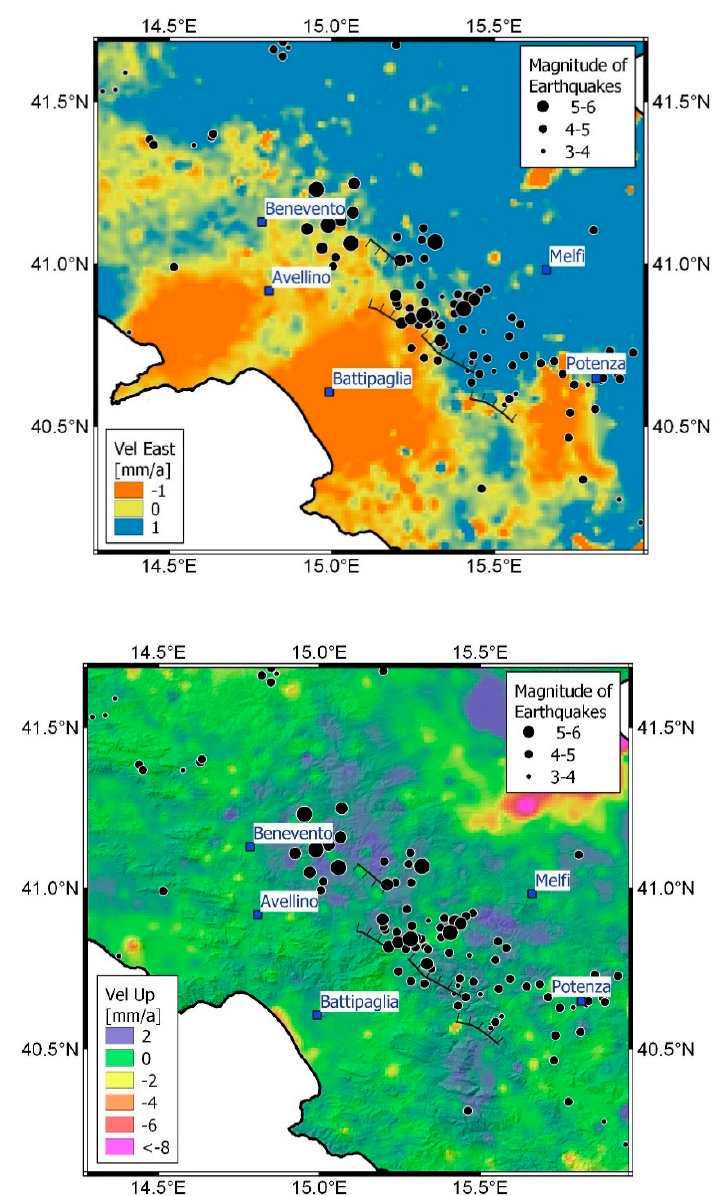
Figure 3. ( Top ) The East component of the ground velocity field of the Irpinia–Sannio area with the main earthquakes of M ≥ 3 occurred since 1900. For the earthquakes of M ≥ 4, the label represents the year of the occurrence. ( Bottom ) Map of the vertical component of the ground velocity in Irpinia with the main earthquakes that occurred from 1466 to 2017. The main towns are drawn and labeled with dark blue squares, and the main faults (see Figure 2 (top)) are represented with black hashed lines.